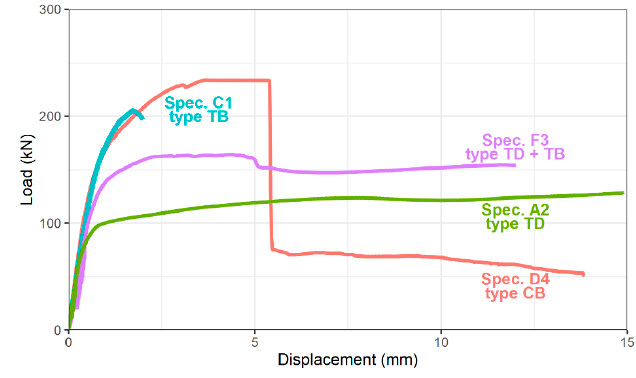
Figure 12. Load-slip curves of different failure types.